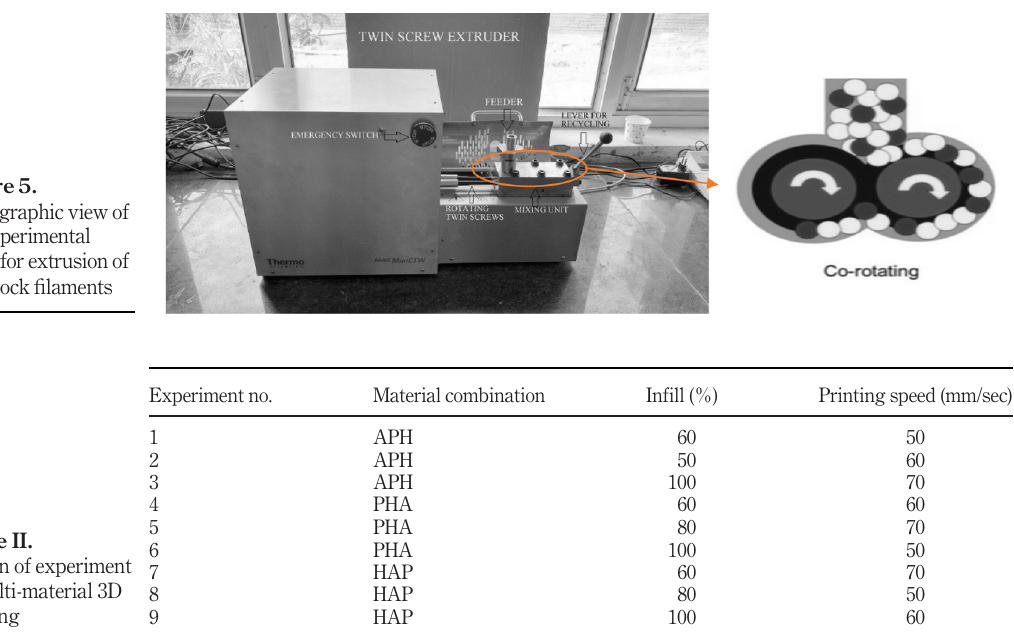
Table II. Design of experiment